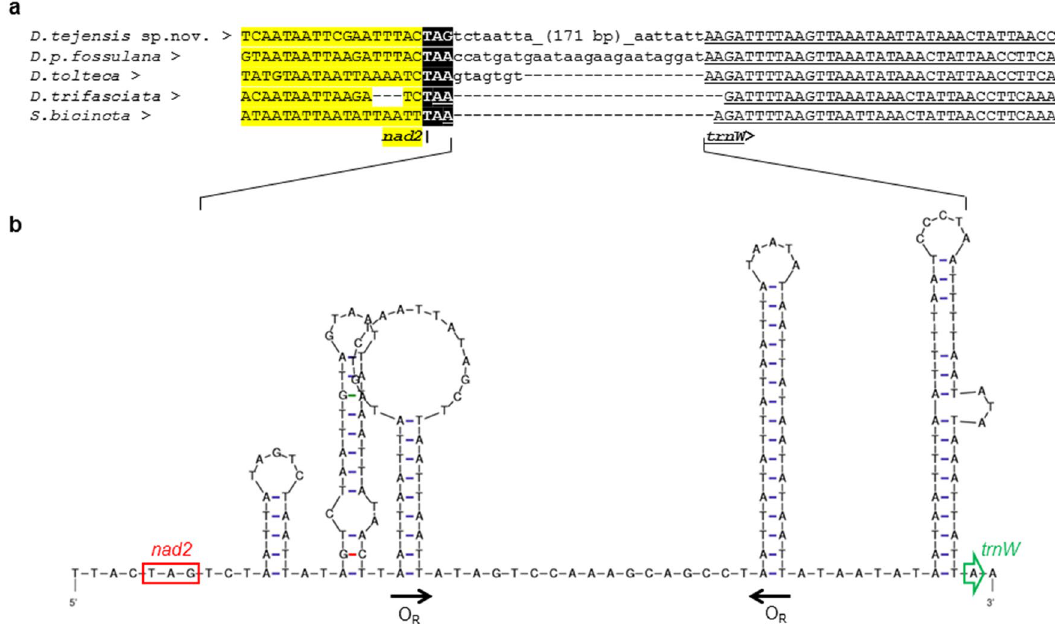
Figure 4. Intergenic nad2-trnW region in Scoliidae mitogenomes. ( a ) Multiple sequence alignment of the nad2-trnW interval (L strand; trnW is underlined). ( b ) Predicted secondary structure of the D. tejensis sp. nov. nad2-trnW region in the single-strand conformation (mfold dG = − 19.06 kcal/mol). O R , putative origin of